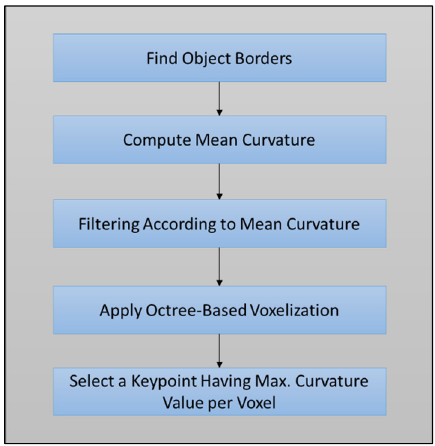
Figure 5. Overview of the major steps of the proposed keypoint detection algorithm.